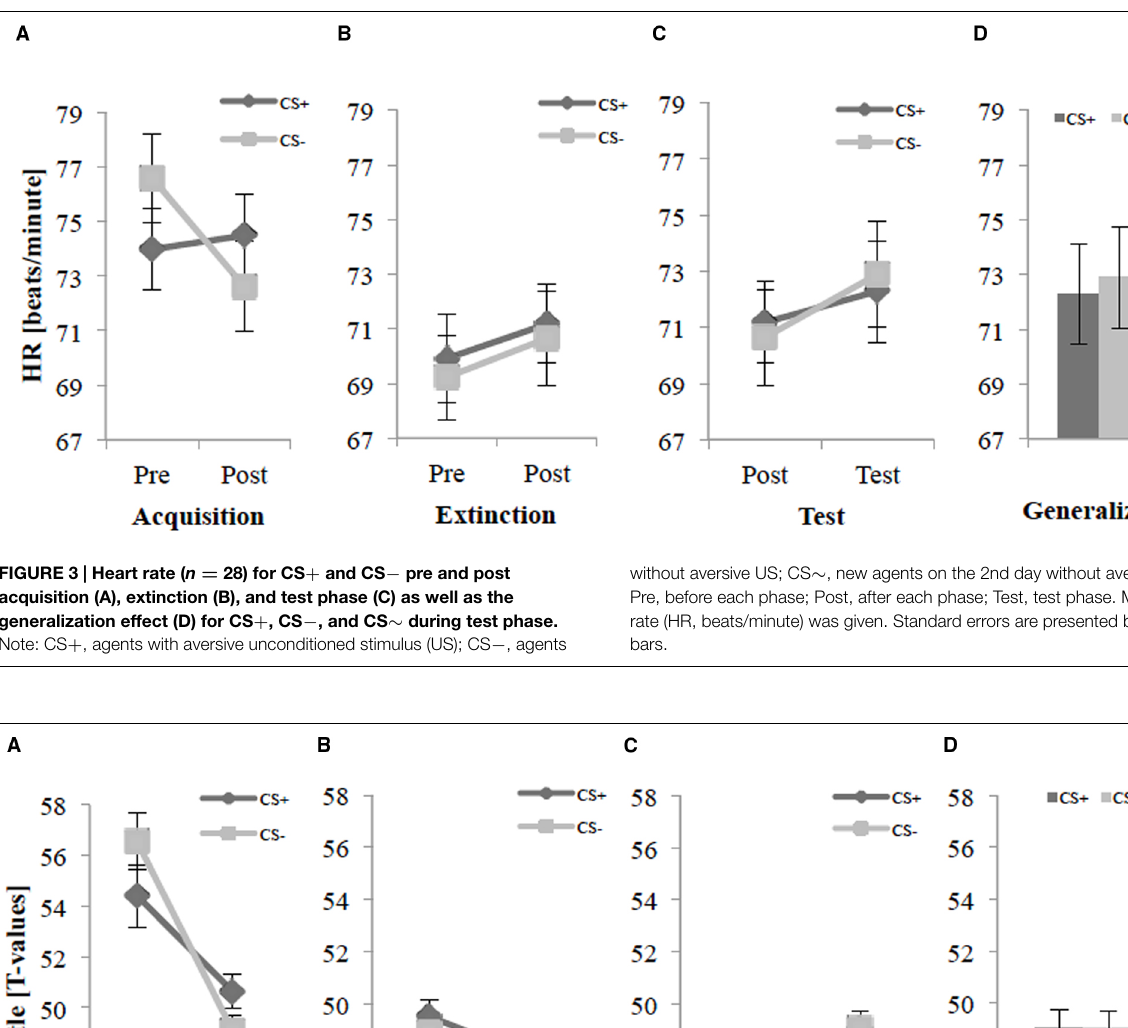
without aversive US; CS (cid:24) , new agents on the 2nd day without aversive US; Pre, before each phase; Post, after each phase; Test, test phase. Mean fear-potentiated startle (presented in T -values) was given. Standard errors are presented by error